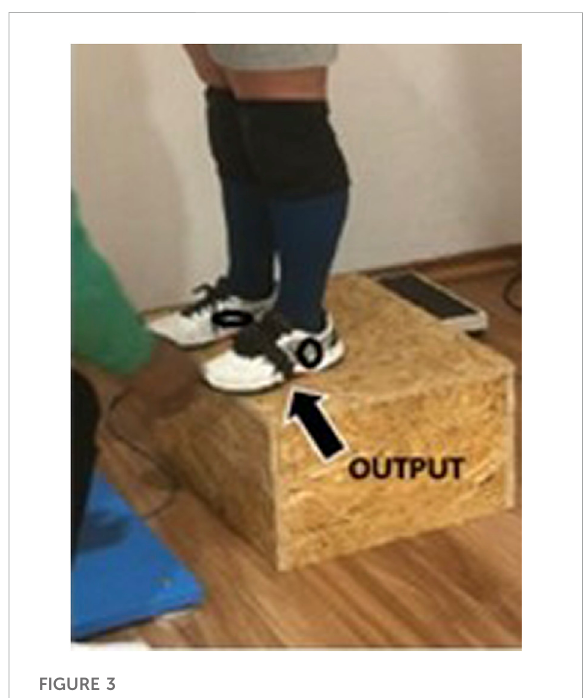
FIGURE 3 OUTPUT mobile inertial unit and the positioning